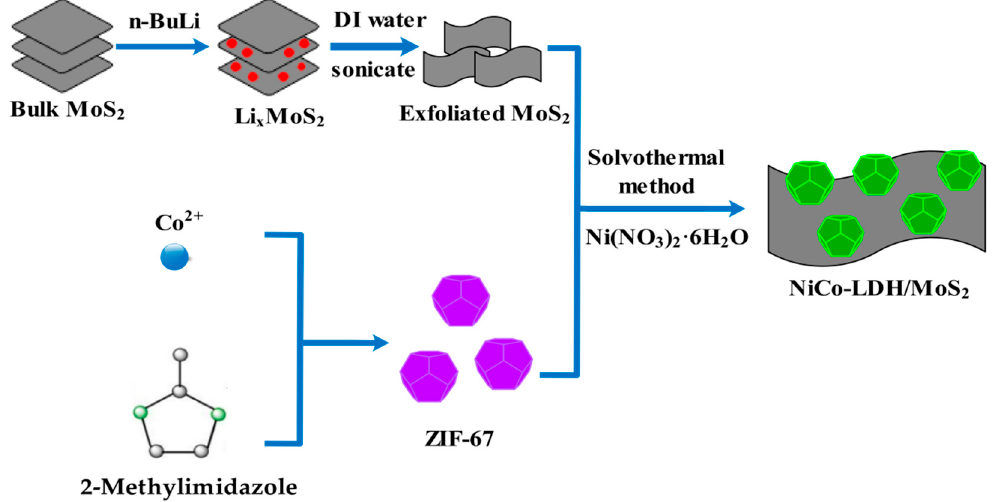
Figure 1. The preparation process diagram of 3D hollow NiCo-LDH/MoS 2.